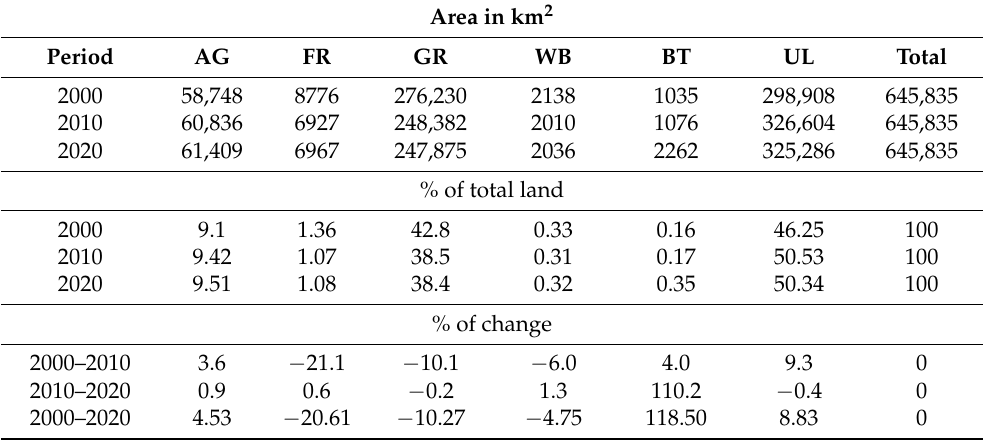
Table 6. Magnitude of LULC change in Afghanistan.